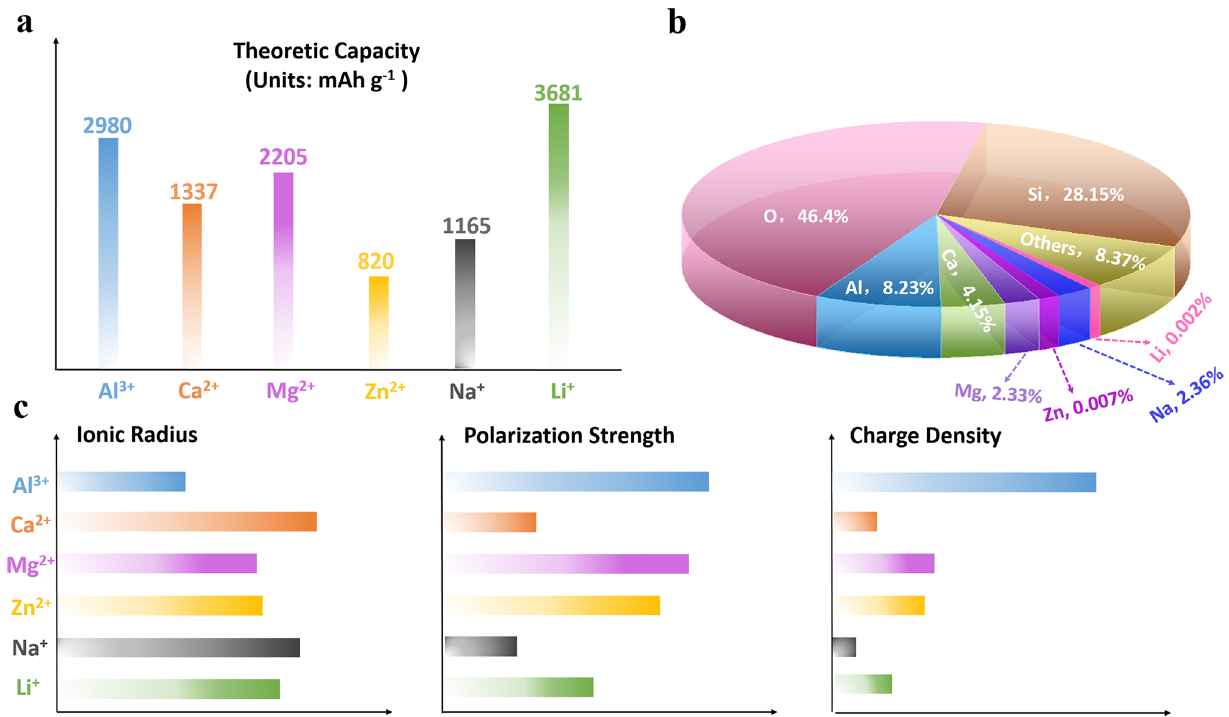
Fig. 8 The intrinsic properties of different inserted ions [110, 111]. a Theoretical capacity. b Content of elements in earth curst. c Comparison of ionic radius, charge density, and polarization of the common inserted